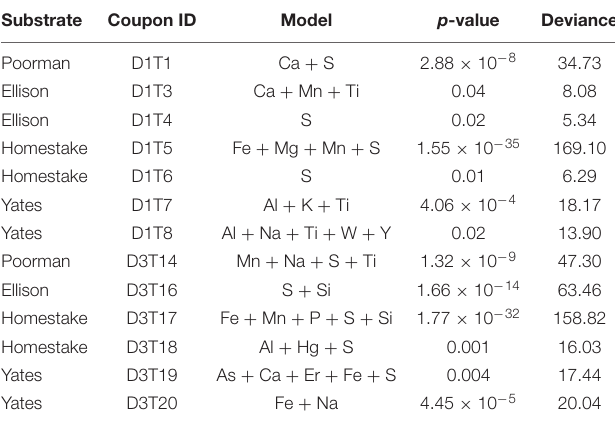
TABLE 2 | Poisson point process model likelihood ratio test